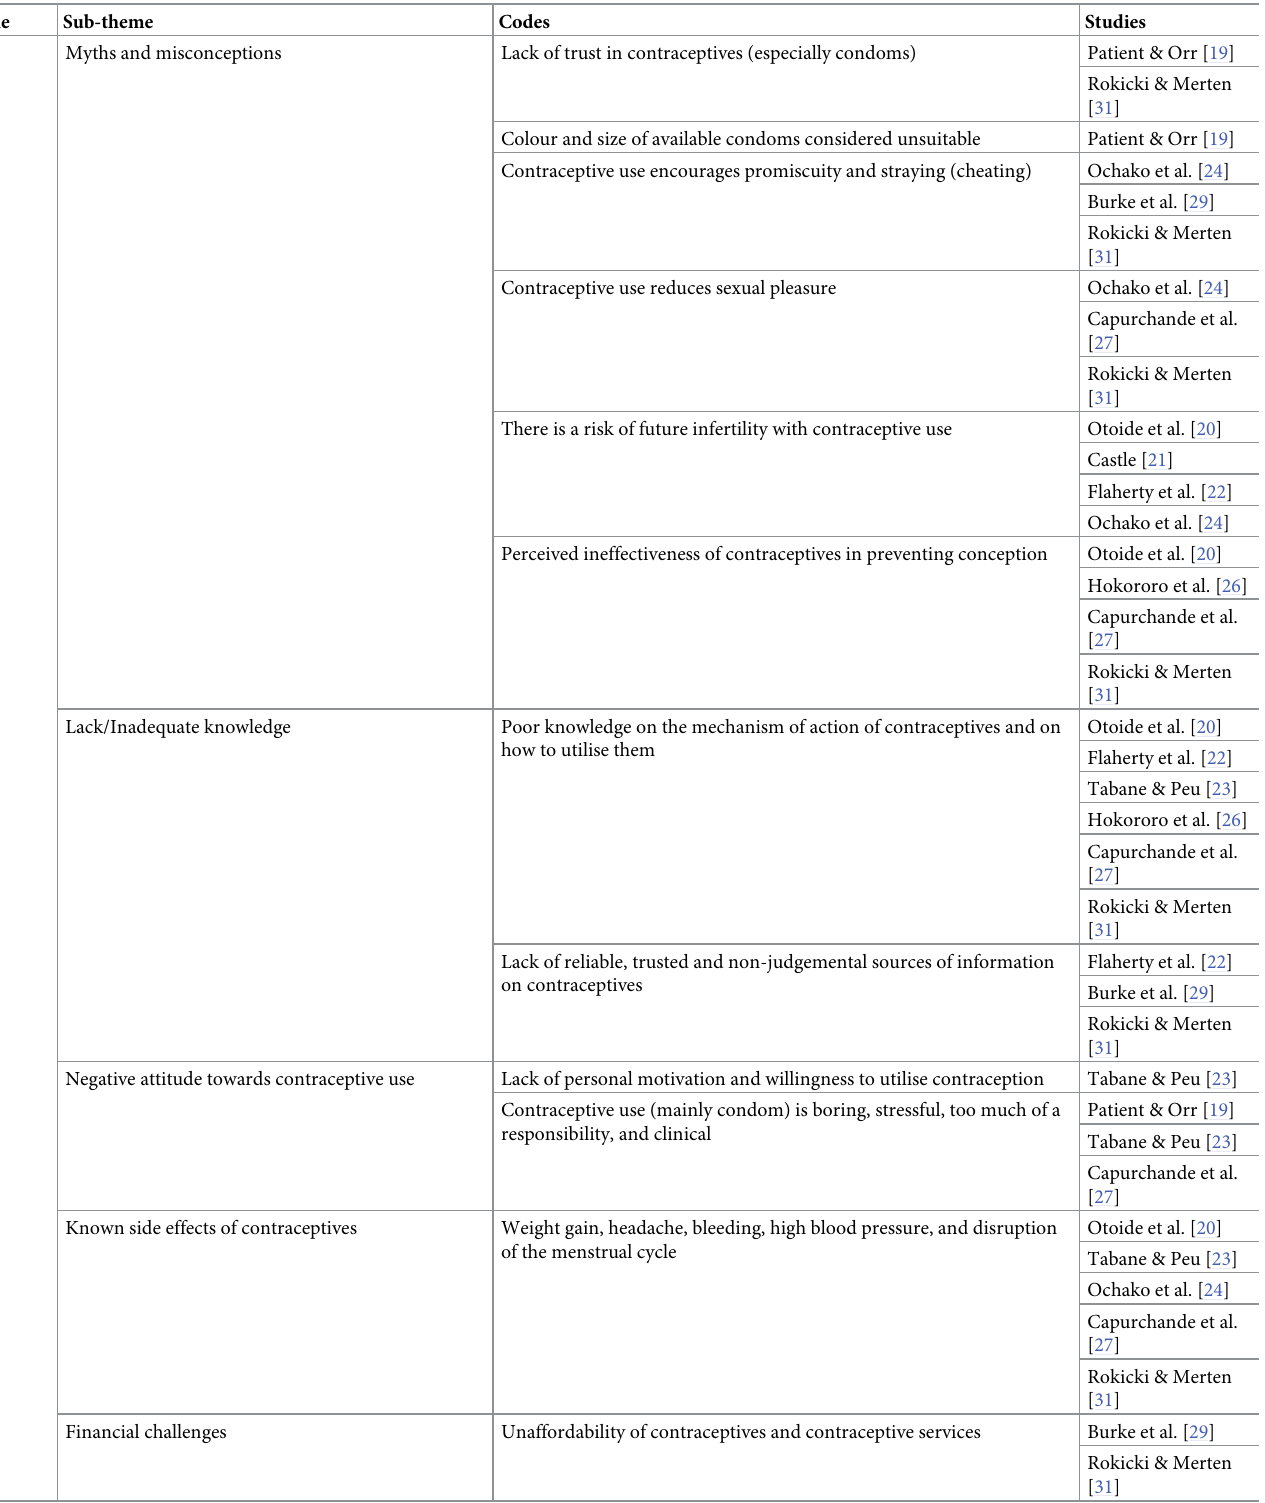
Table 3. Barriers to contraceptive use among young people in